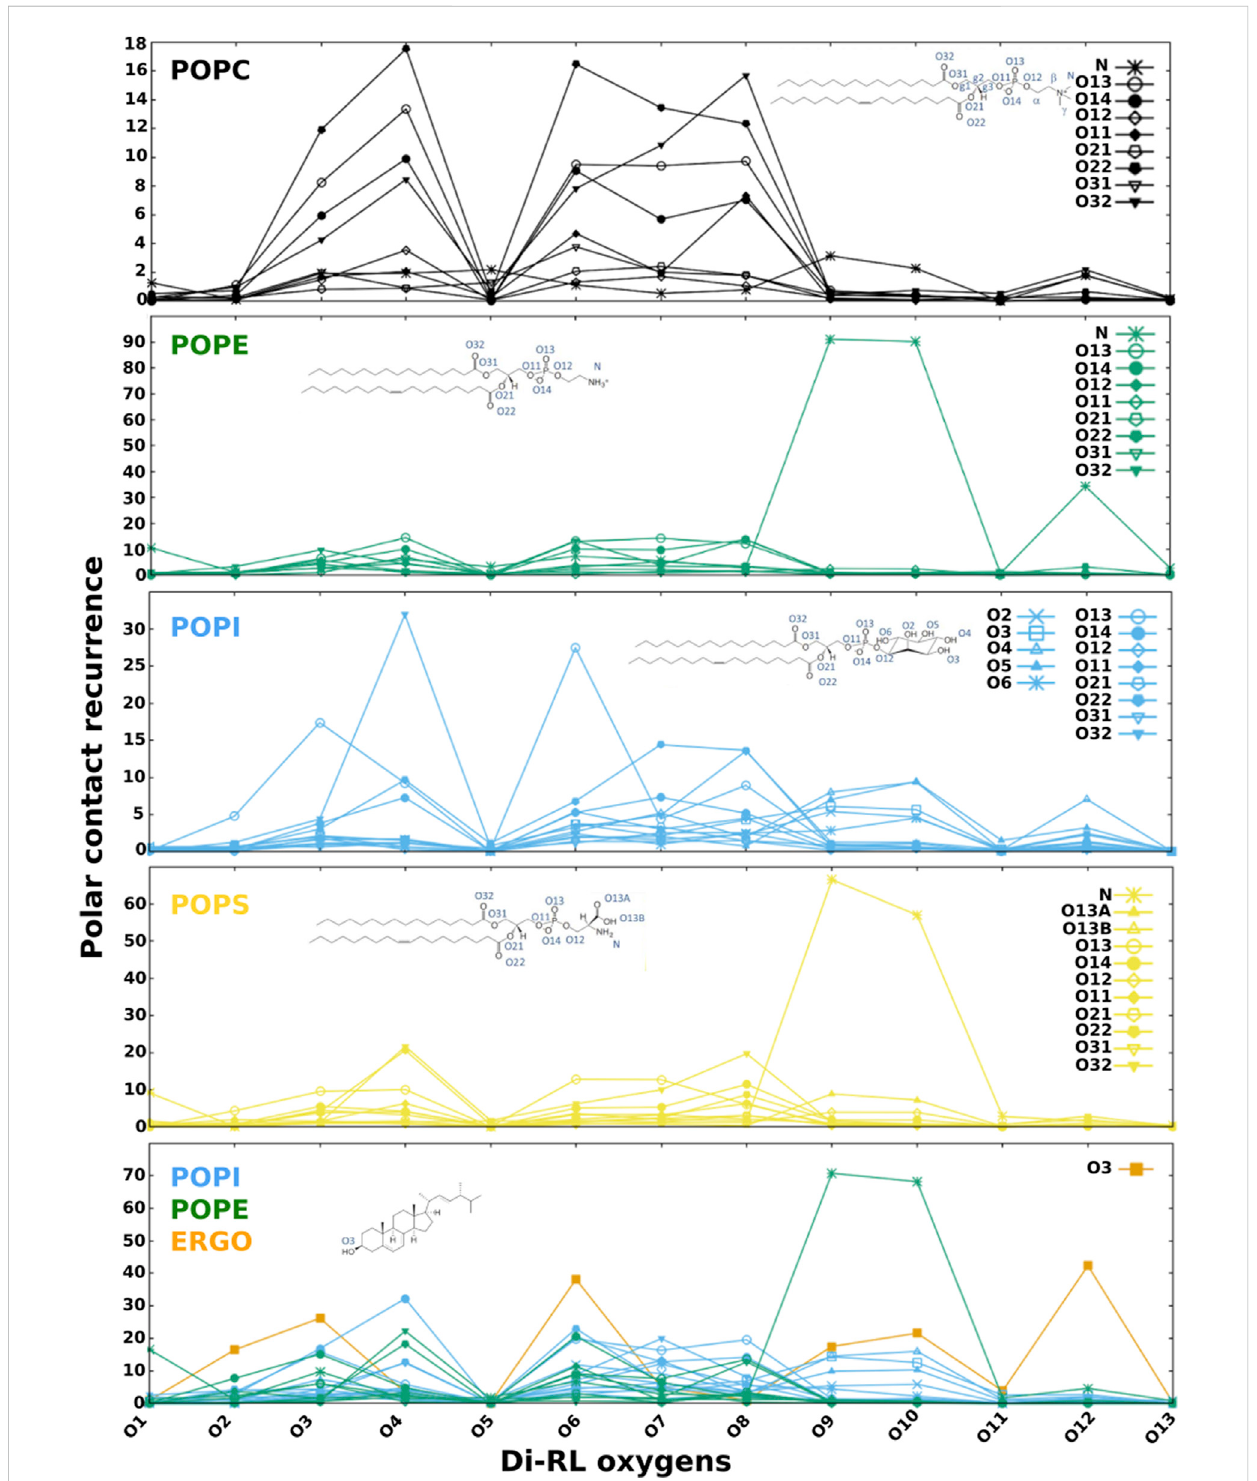
FIGURE 5 Recurrence of close contacts between polar atoms of di-RLs and those of phospholipids, indicating the formation of H-bonds or salt bridges. Membrane models: POPC; POPE; POPI; POPS; a simpli fi ed model of fungal membrane composed of POPE, POPI and ERGO (35/35/30).